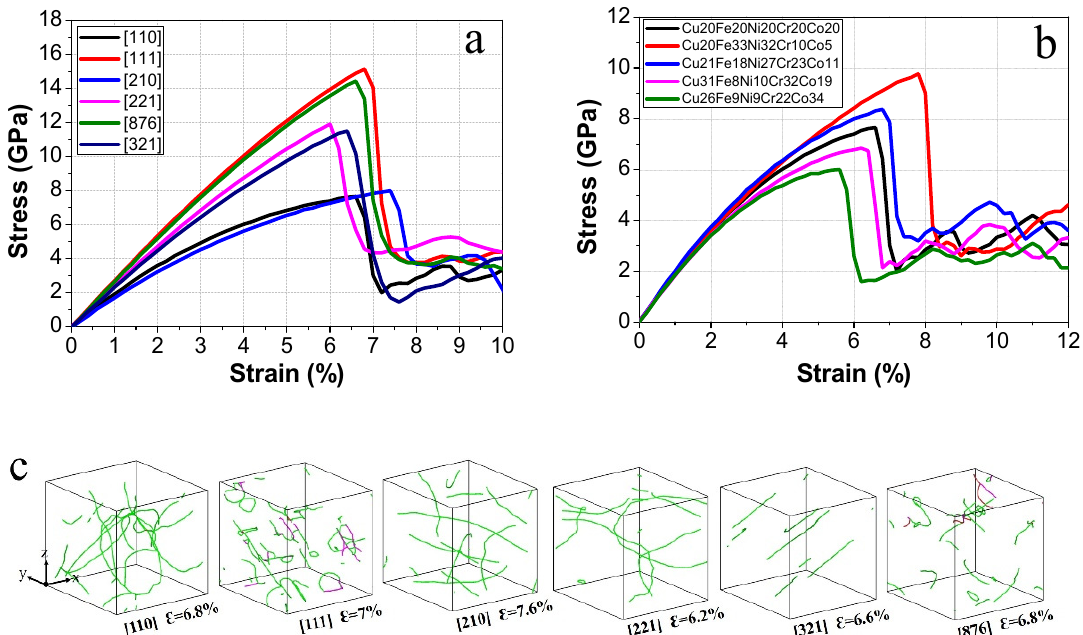
Figure 3. Mechanical responses of single-crystal HEA samples. ( a ) Stress-strain response of the equiatomic single-crystal HEA samples with different crystallographic orientations. ( b ) Stress-strain response of the single-crystal HEA samples with different element compositions along [110] orientation. ( c ) Snapshots of the nucleation of the first set of dislocations in the single-crystal samples with different orientations near the yield point. ε indicates the tensile strain.